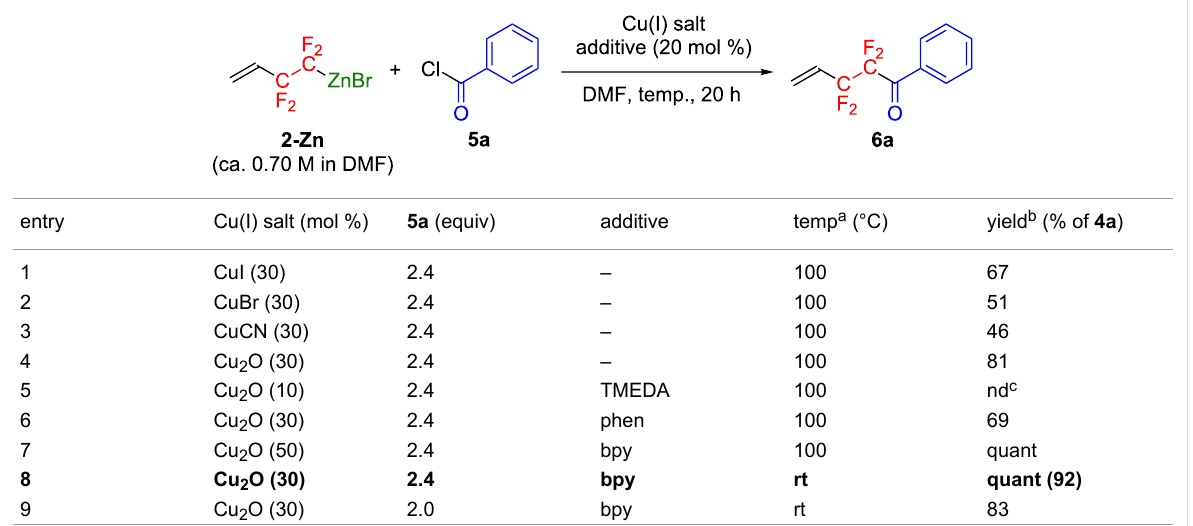
tion in an environmentally benign protocol, we conducted the reaction with a decreased amount of 5a . Unfortunately, this slightly lowered the yield of 6a (Table 3, entry 9).